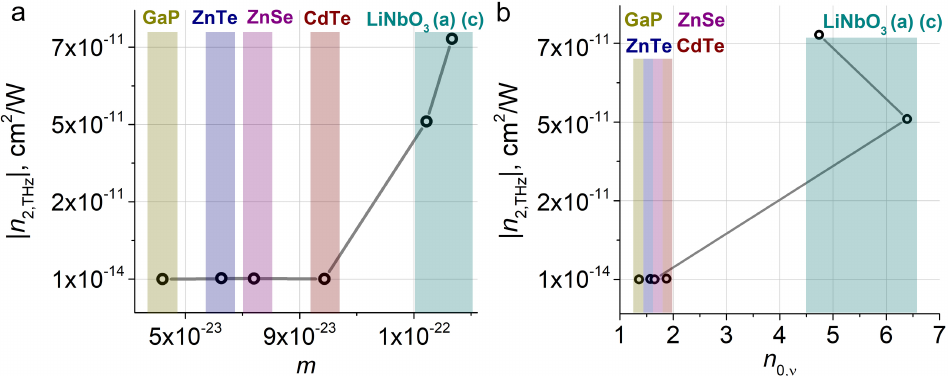
Figure 2. The nonlinear refractive index coefficient dependence on the medium parameters for different crystals: ( a ) m describes the reduced mass of the vibrational mode and ( b ) n 0, ν describes the vibrational contribution to the low-frequency refractive index (see Equation (1)